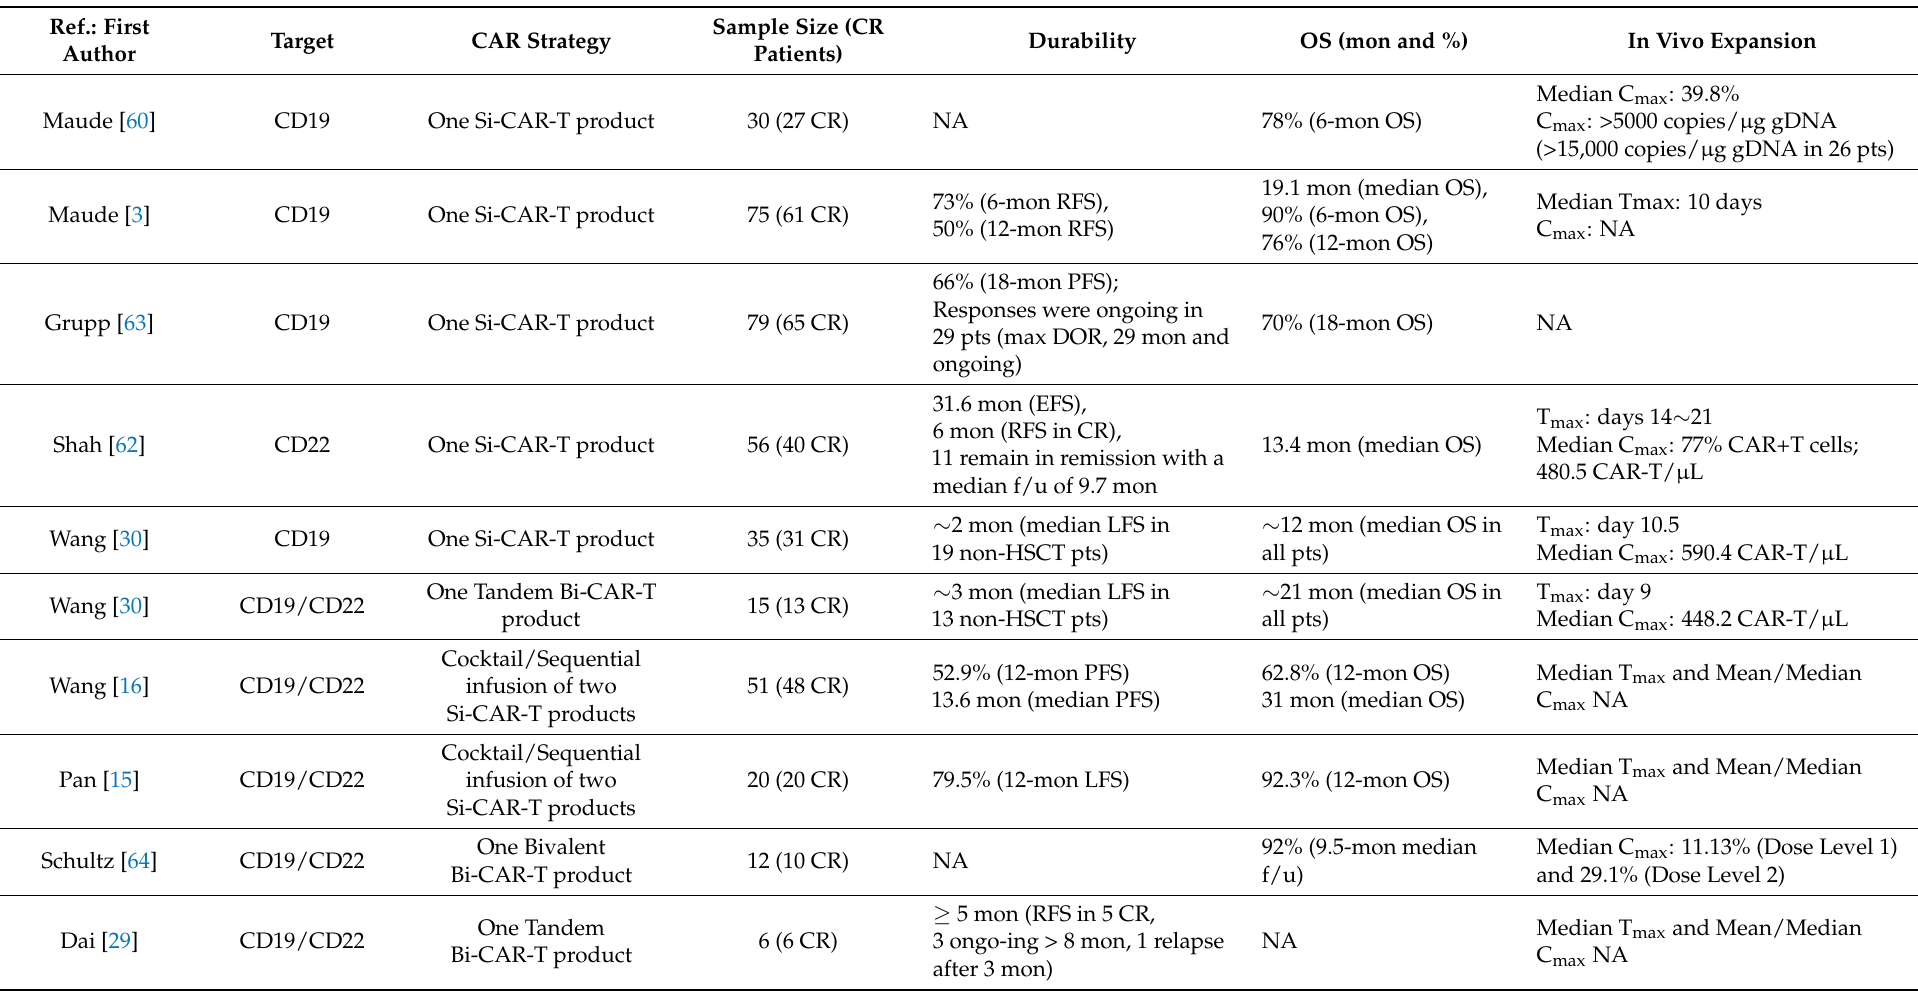
Table 3. Comparison of dual-targeting CD19/CD22 CAR T-cell therapy with the respective Si-CAR T-cell therapy with respect to duration of response, survival, and expansion in